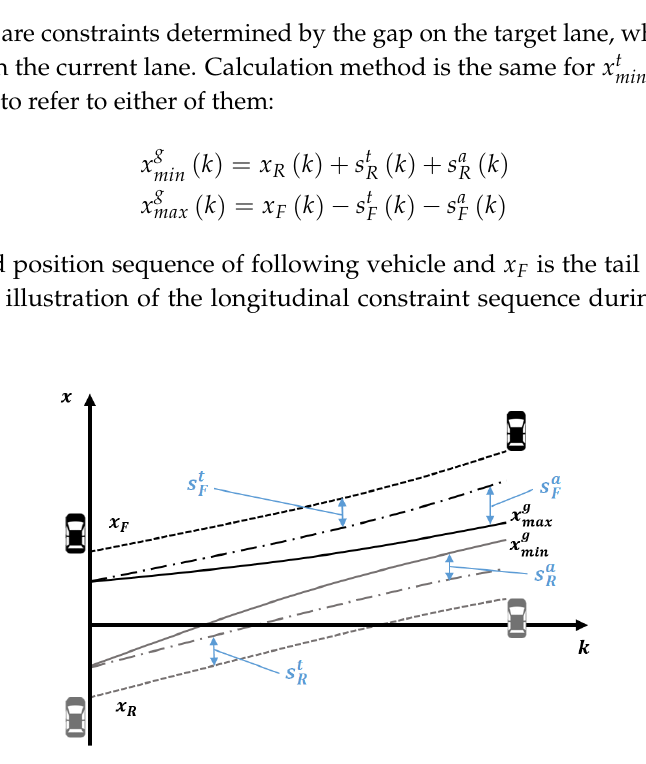
+ d 0 , which remains relatively constant, F